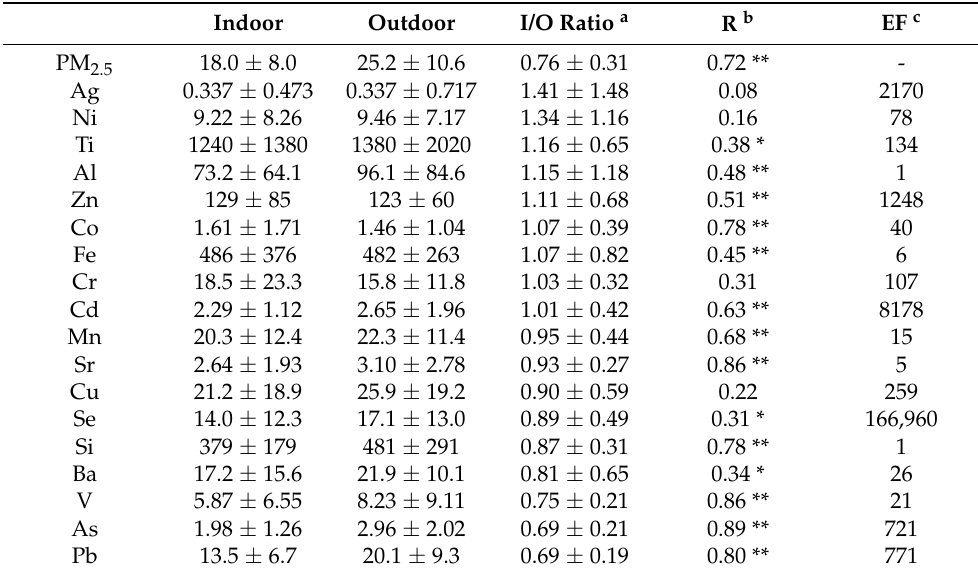
Table 1. Concentrations of PM 2.5 ( µ g/m 3 ) and trace elements (ng/m 3 ) in indoor and outdoor air (mean ± standard deviation). Indoor Outdoor I/O Ratio a R